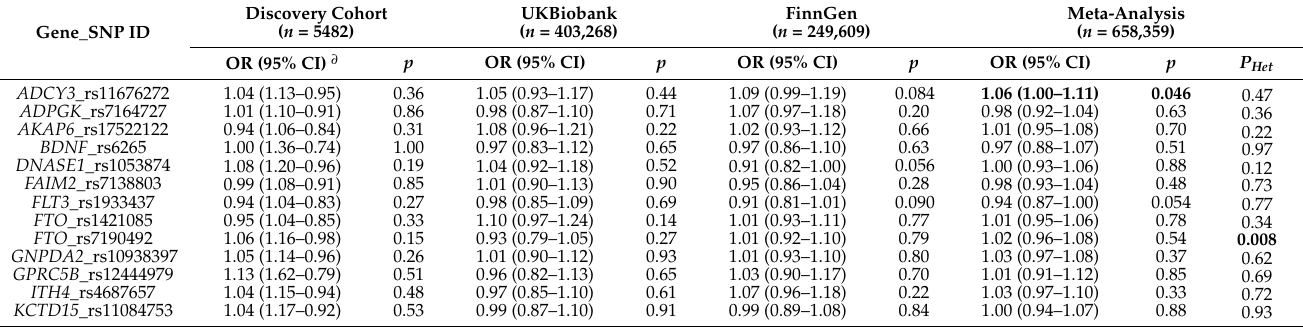
Table 1. Meta-analysis of the discovery cohort with GWAS data from the UKBiobank and FinnGen